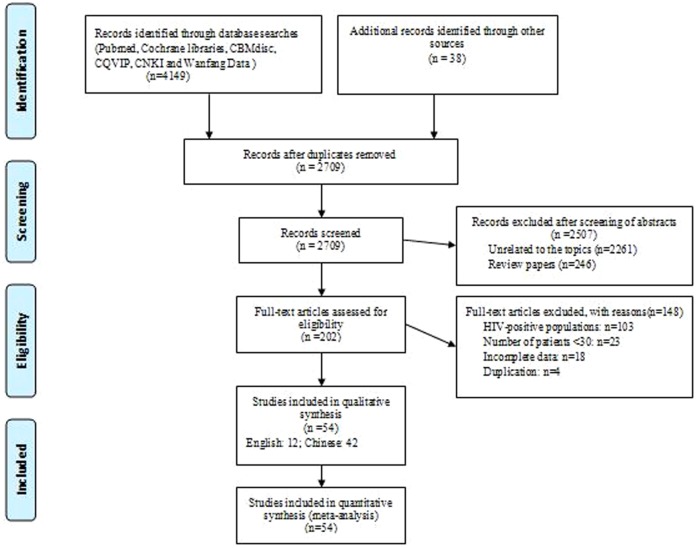
Flow chart showing the meta-analysis studies selection.n, the number of prevalence estimates included in meta-analysis.